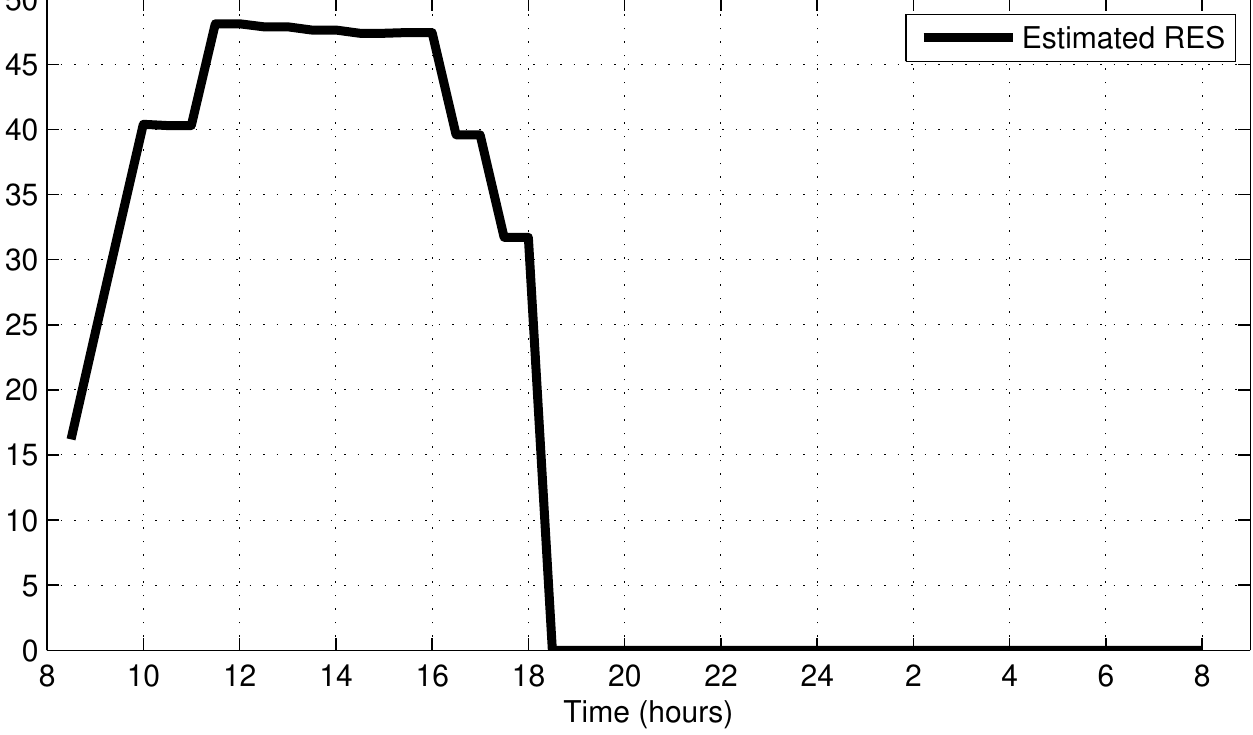
Figure 10. The estimated day-time solar energy